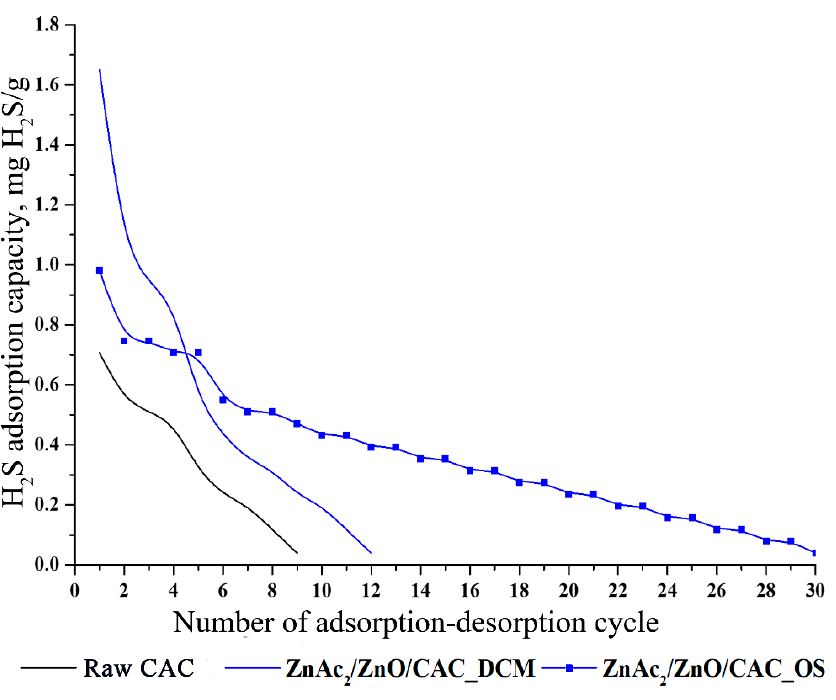
Figure 9. Maximum H 2 S adsorption–desorption profiles of ZnAc 2 /ZnO/CAC_DCM, ZnAc 2 /ZnO/CAC_OS, and raw CAC.